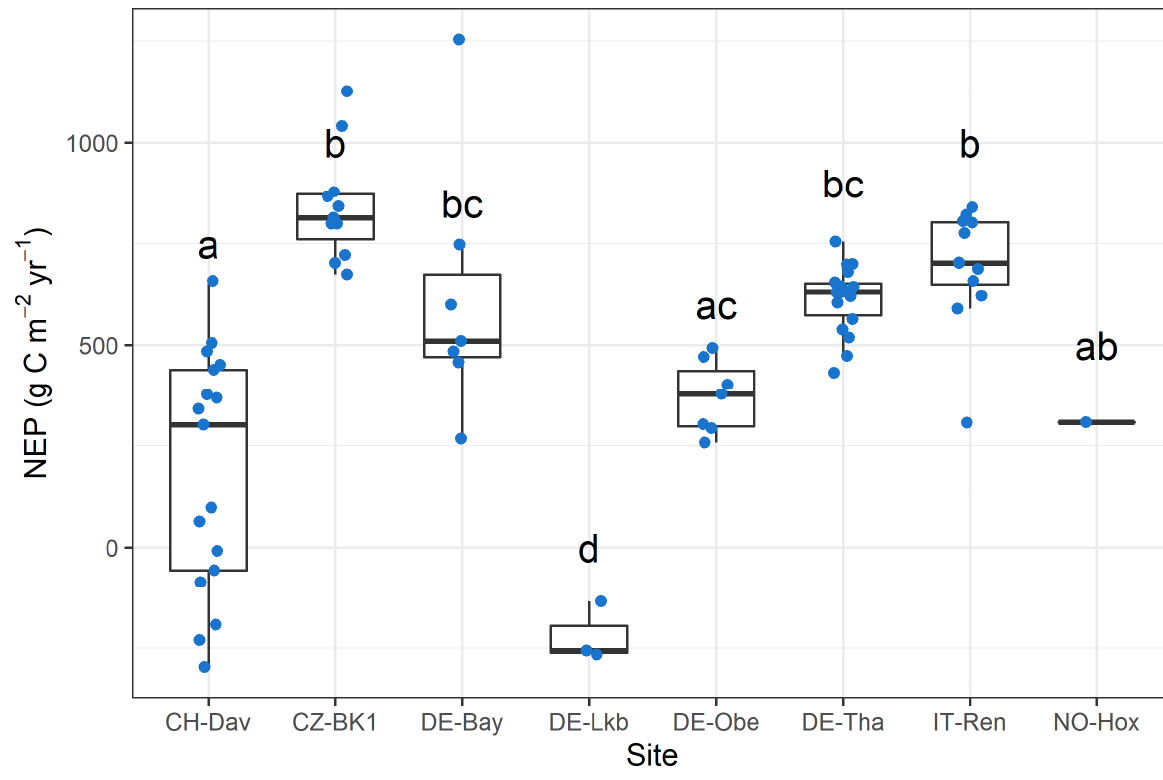
Figure 2. Annual NEP at each study site. The solid lines in the boxes are medians. The lower and upper hinges are the first and third quartiles, respectively. The upper and lower whiskers represent the largest and smallest values within 1.5 times of the interquartile range (distance between the first and third quartiles) from the hinge. Blue points are annual NEP values. Different letters above the boxes indicate significant differences in NEP among the sites ( p < 0.05) based on one-way ANOVA followed by Tukey’s HSD test.